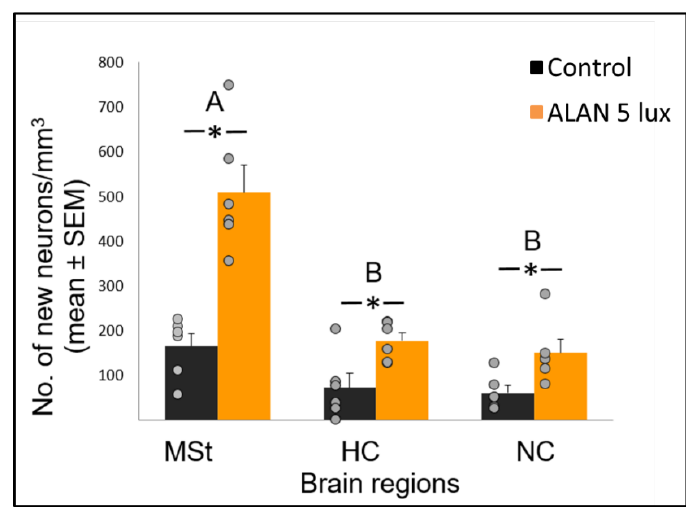
Figure 1. Neuronal recruitment (number of new neurons per mm 3 ; mean ± SE) in three brain regions—medial striatum (MSt), hippocampus (HC) and nidopallium caudale (NC), of birds exposed to 5 lux ALAN and controls that remained in dark nights. Grey dots indicate individual data points, * indicates a significant difference between groups ( p < 0.05), and different letters indicate significant differences between brain regions ( N = 6 birds/group).